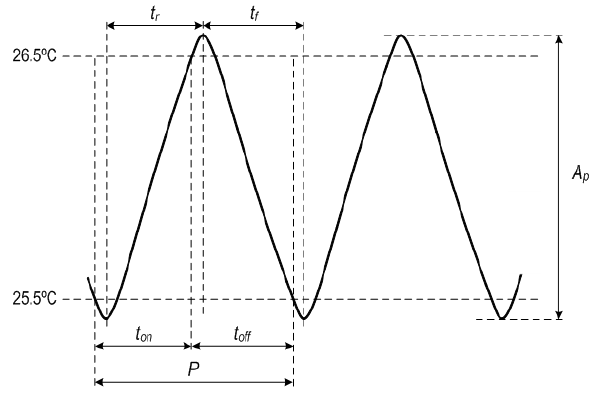
Figure 10: Parameters of the temperature oscillations at the steady